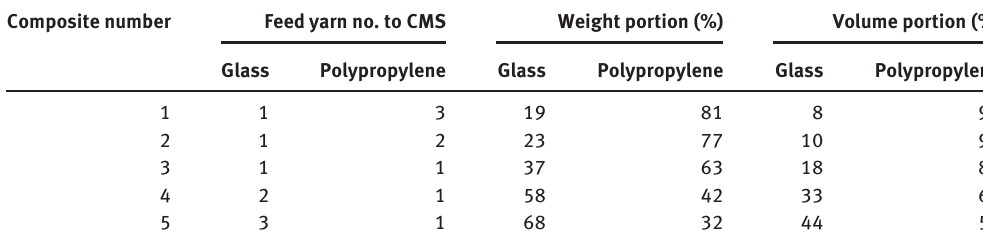
Table 1 Polypropylene and glass fiber content in